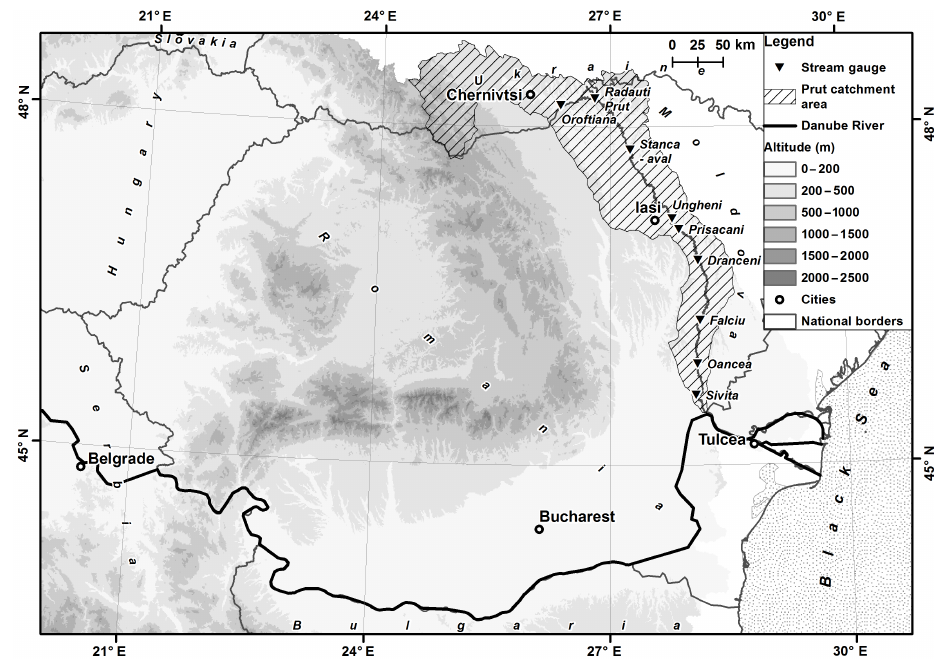
Figure 2. Geographic position of the Prut catchment basin in Romania, Ukraine, and the Republic of Moldova, and distribution of the main gauging